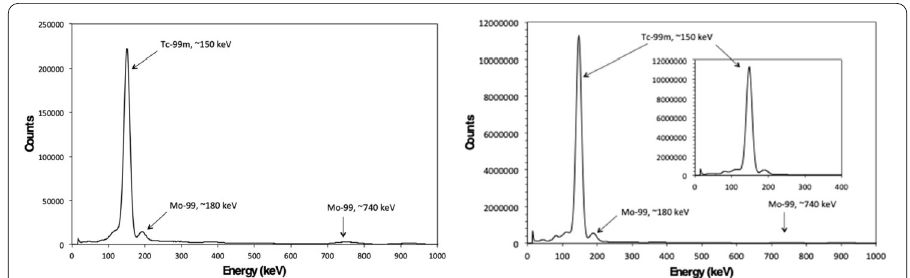
Figure 5 (Left) Gamma spectrum of Mo cube after 26 h post EOB showing characteristic peaks for 99 Mo and 99 m Tc. (Right) Gamma spectrum (12 h count) of Mo foil acquired 24 h after EOB